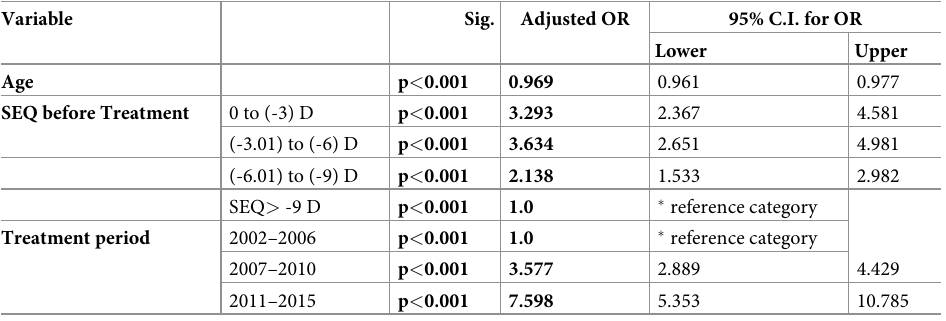
Table 10. Logistic regression